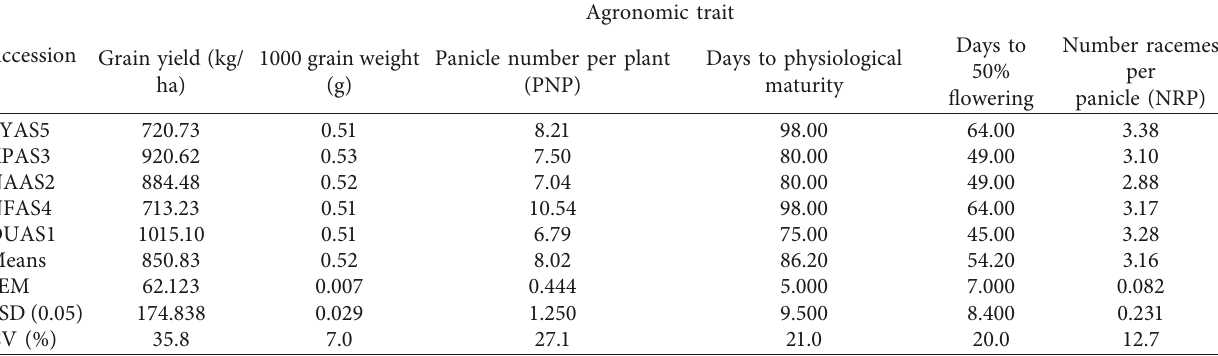
Table 4: Effect of accession on yield and yield